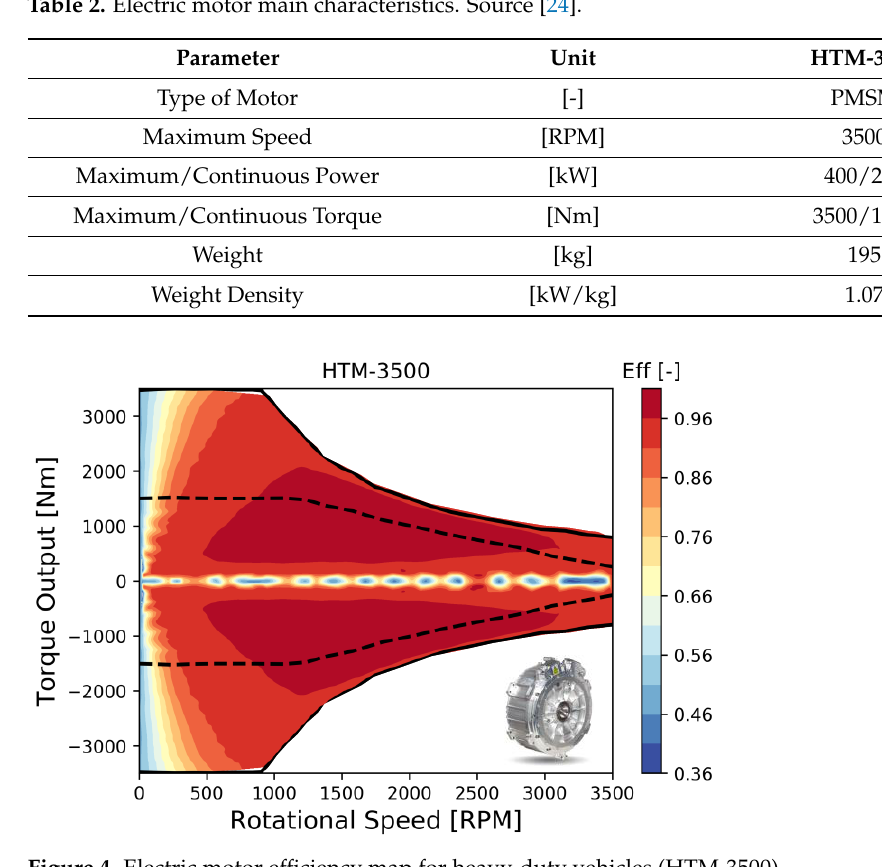
Figure 4. Electric motor efficiency map for heavy-duty vehicles (HTM-3500).